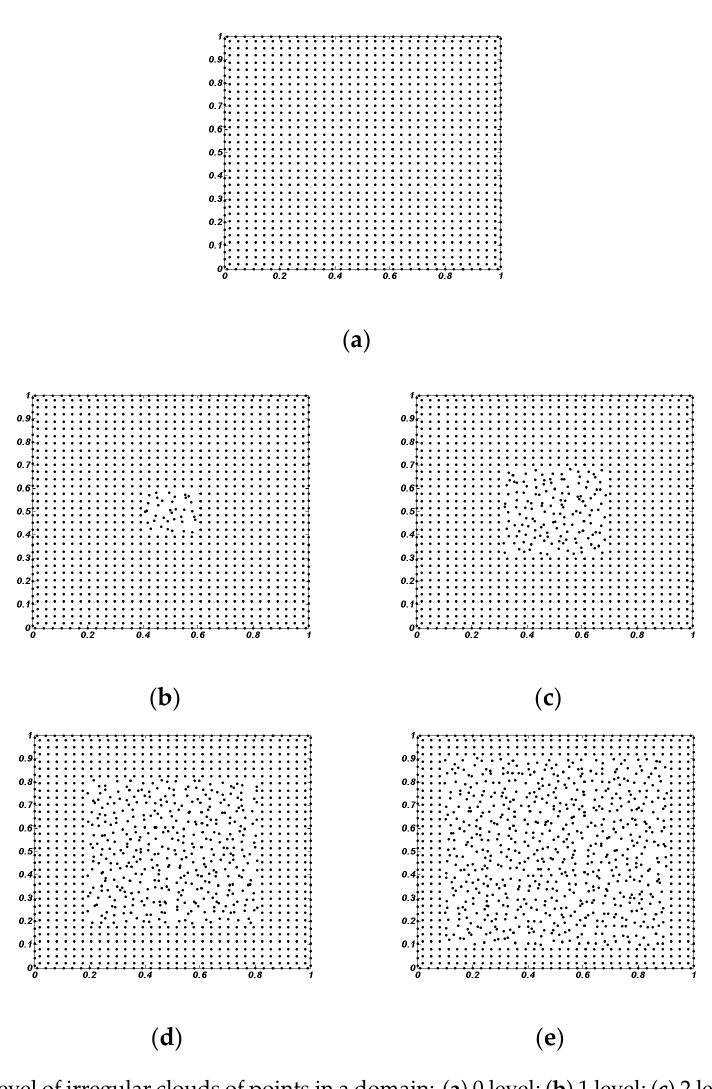
Figure 9. The level of irregular clouds of points in a domain: ( a ) 0 level, ( b ) 1 level, ( c ) 2 level, ( d ) 3 level, and ( e ) 4 level.